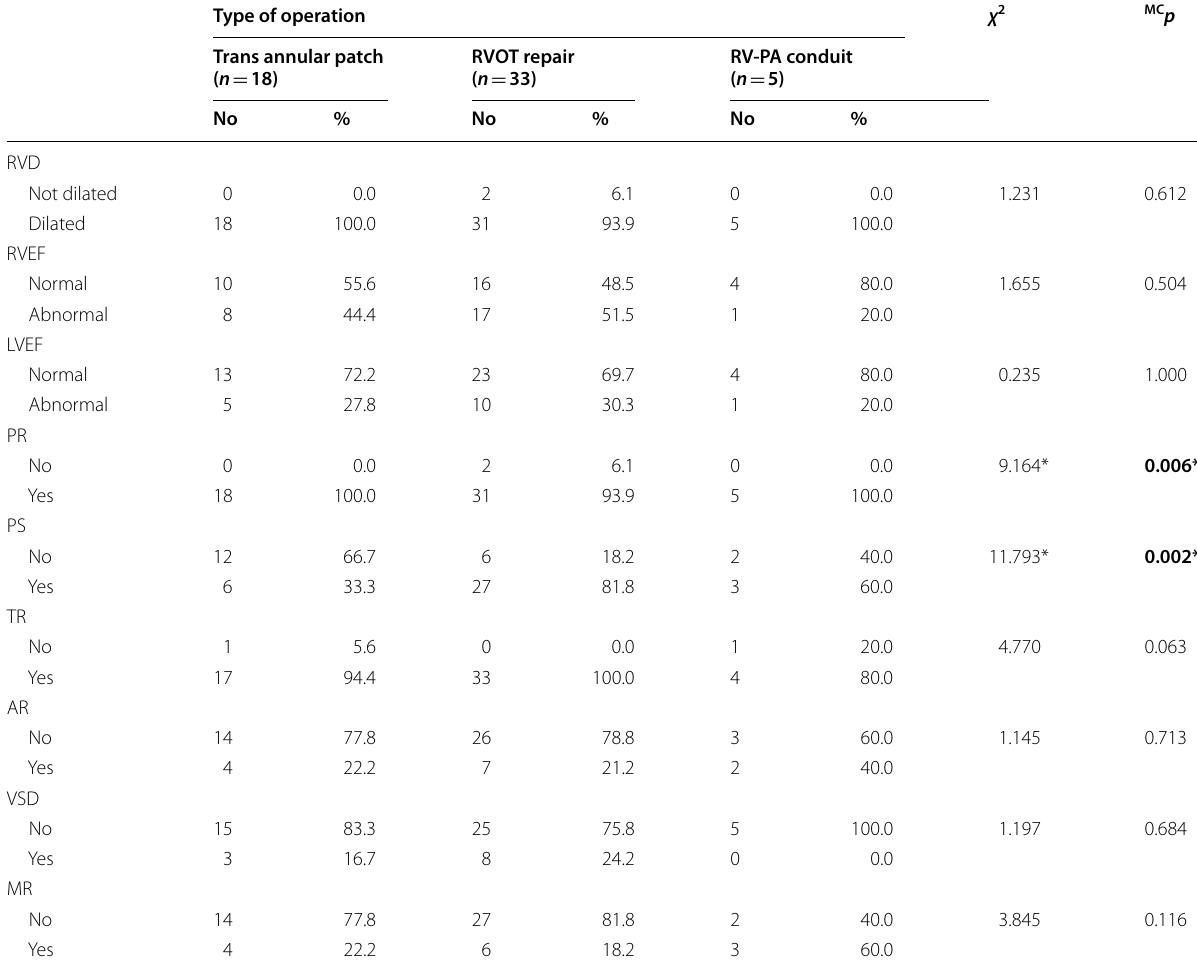
Bold inidciates statistically significant values